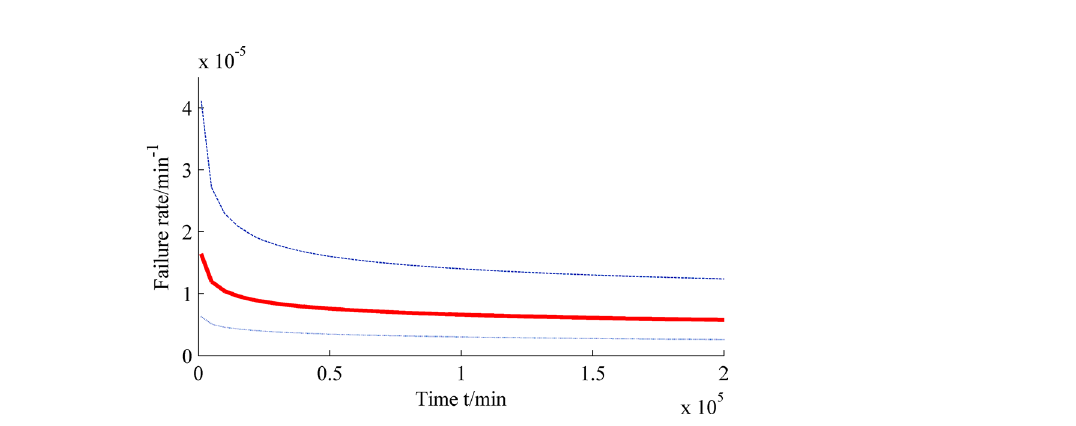
Figure 5. Interval estimation of failure rate. Figure created using Matlab R2014a (https:// www. mathw orks.